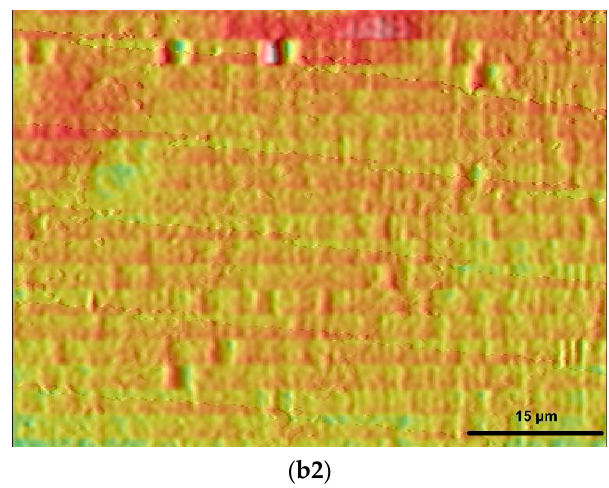
Figure 1. Heating-responsive shape recovery after indentation at room temperature. ( a1 , a2 ) are 3D view and top view of the indent, respectively; ( b1 , b2 ) are 3D view and top view of the surface after heating, respectively. The scale bar in the subfigures of the right column is 15 μ m.